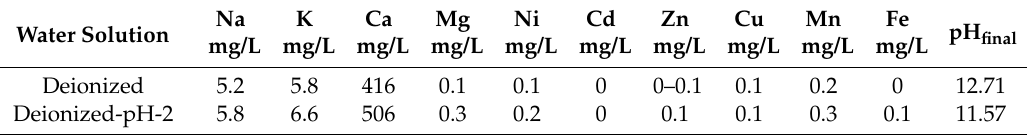
Table 3. Soluble concentration of some elements in water from Bottom ash.